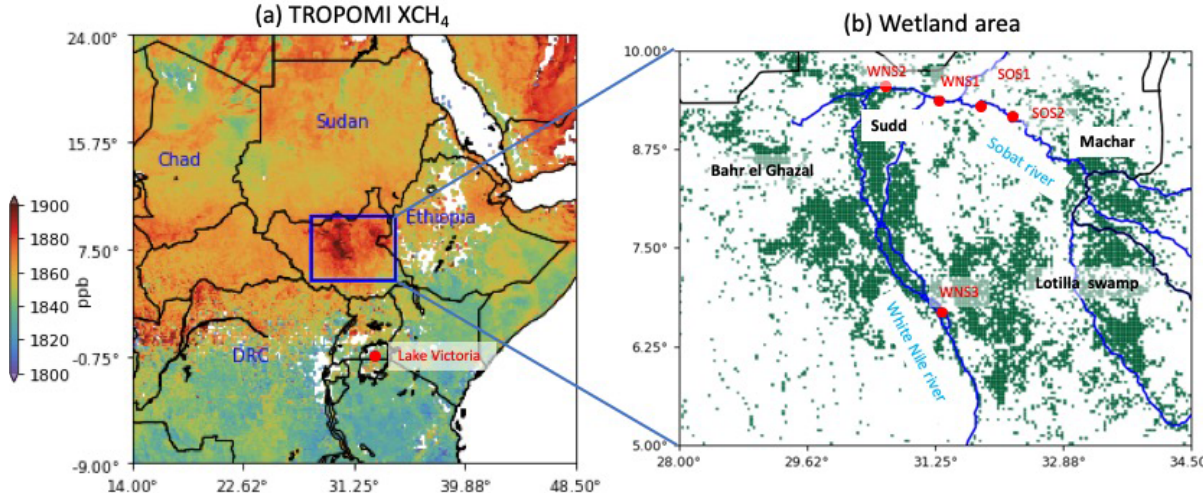
Figure 1. The TROPOMI XCH 4 enhancement over the South Sudan wetlands. (a) Average of 2 years (December 2017 to November 2019) of TROPOMI XCH 4 at 0.1 ◦ × 0.1 ◦ resolution. (b) Wetlands in South Sudan from Gumbricht et al. (2017) are shown in green, and the rivers in the region are shown in blue. The area within the blue rectangle (5–10 ◦ N and 28–34.5 ◦ E) is referred to as the South Sudan wetlands region (SSWR). The red dots show the locations of satellite-altimetry-based river water height measurement sites.